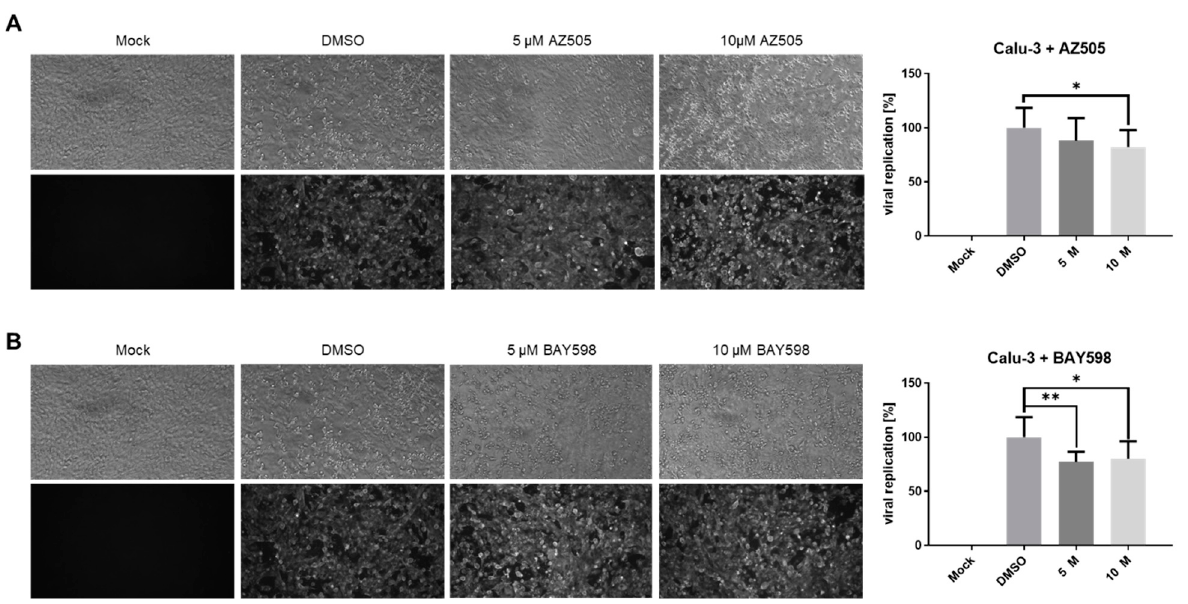
Figure 7. Inhibition of SMYD2 in Calu-3 cells slightly impedes SARS-CoV-2 replication. ( A , B ) Antiviral effect of AZ505 and BAY598 in Calu-3 cells. Cells were treated with the indicated concentrations for 24 h prior to infection. The same amount of inhibitor was also applied together with the virus (MOI = 0.005). SARS-CoV-2 positive cells were visualized two days post-infection using a mAb against Spike and an Alexa488-conjugated secondary antibody under a Nikon Inverted Ts2-FL Eclipse microscope equipped with a 10x objective. The Alexa488 signal was quantified in a Victor X4 multilabel reader. Bar graphs represent mean values of eight infected wells ± SD. ** p < 0.01. * p < 0.05. N.S., not significant. One representative experiment out of three replicates is shown.